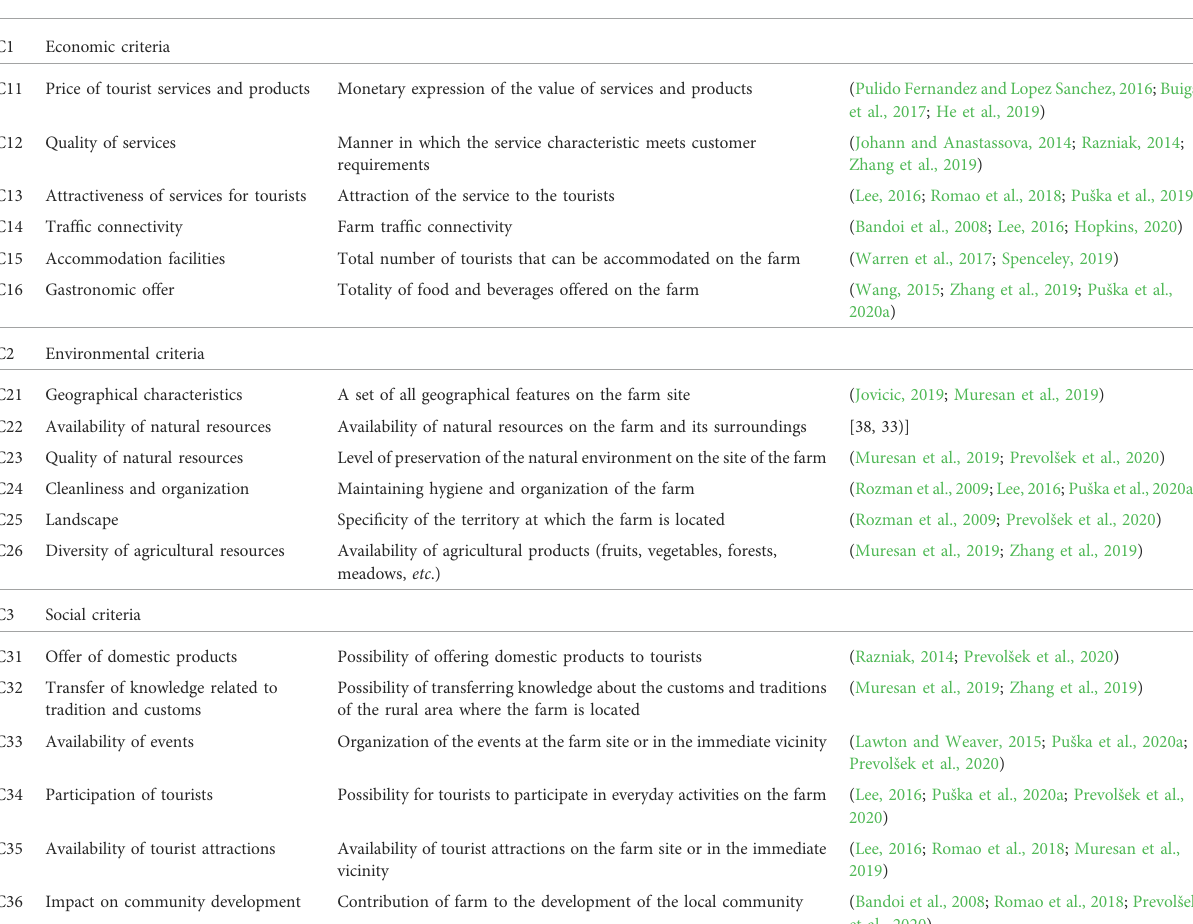
TABLE 2 Decision